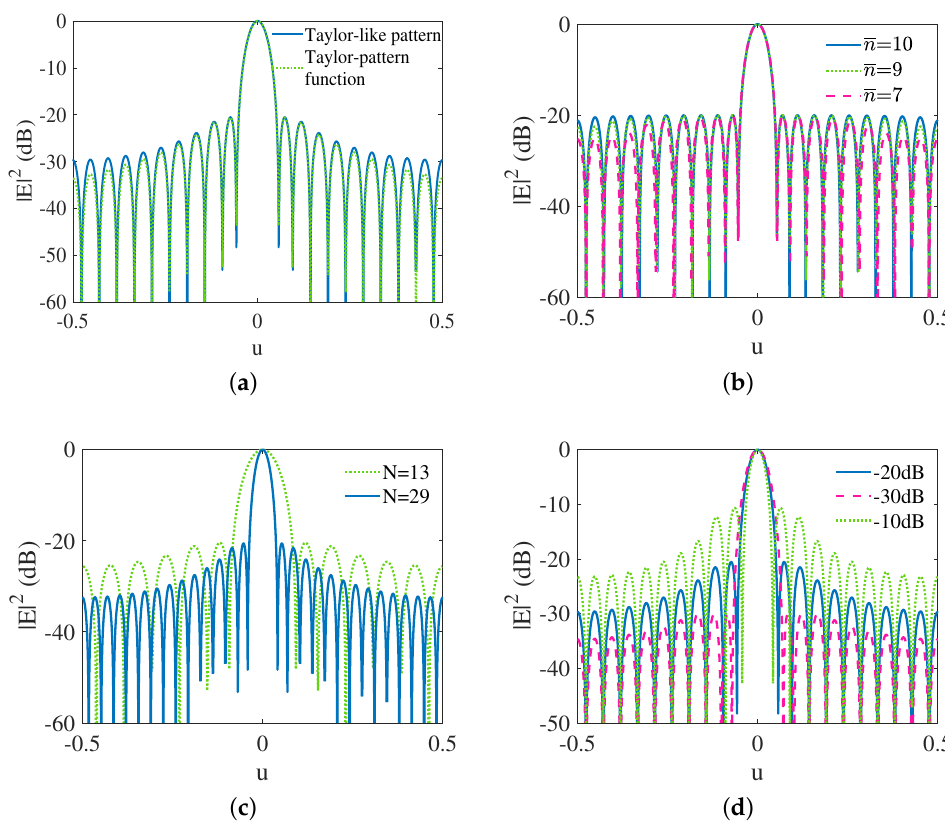
Figure 3. ( a ) Comparison of Taylor-like patterns produced by the Schelkunoff’s polynomial method (blue line) and the Taylor-pattern function (green dotted line) where N = 21, n = 3 and cos π A = 20 dB. ( b ) Taylor-like patterns where n is 7 (red dashed line), 9 (green dotted line) and 10 (blue line) respectively, cos π A = 20 dB and N = 21. ( c ) Taylor-like patterns where N is 13 (green dotted line) and 29 (blue line) respectively with the same λ /2 element spacing, cos π A = 20 dB and n = 3. ( d ) Taylor-like patterns where the first sidelobe level is − 10 dB (green dotted line), − 20 dB (blue line) and − 30 dB (red dashed line) respectively, N = 21 and n = 3.